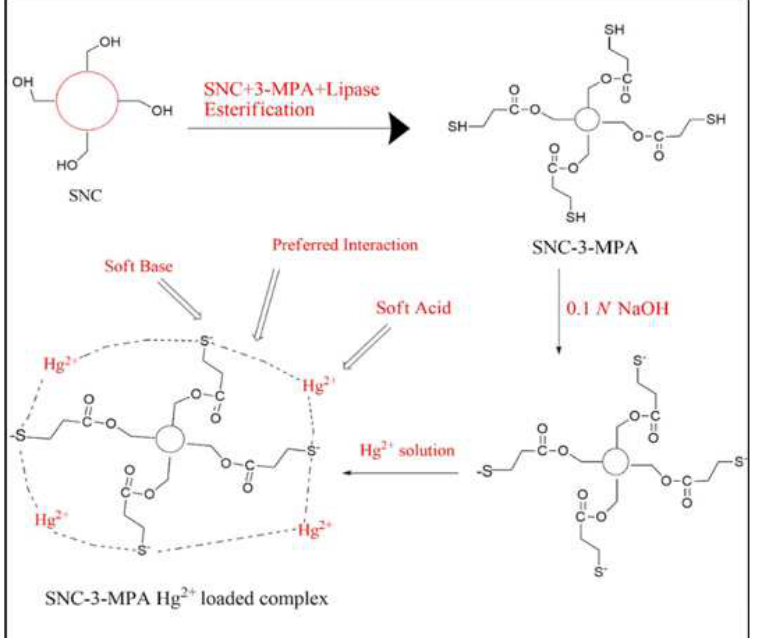
Figure 6. Synthetic route for SNC-3-MPA and mechanism of its Hg 2+ ions adsorption. Adapted with permission from [58]. Copyright 2018 Elsevier. permission from [58]. Copyright 2018